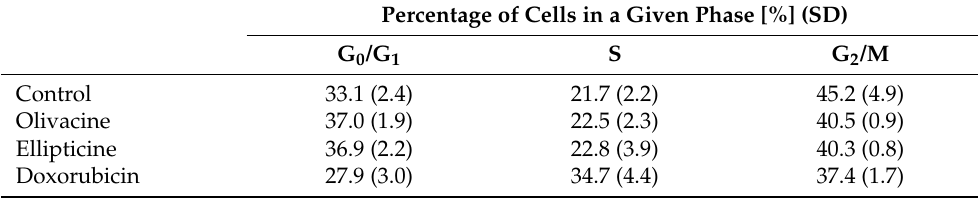
Table 3. Percentage of CCRF/CEM cells in various cell cycle phases after 24 h exposure to olivacine, ellipticine, and